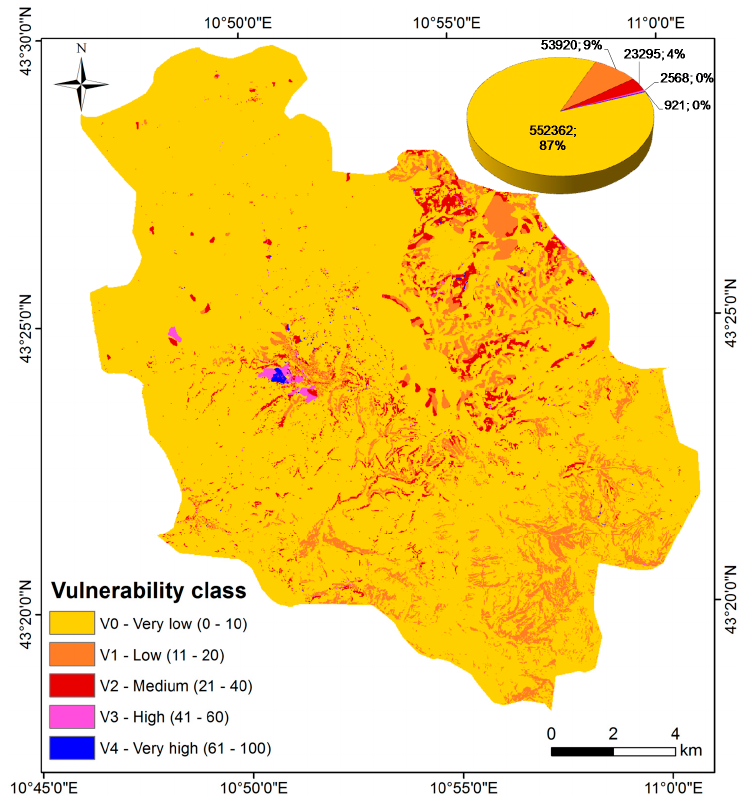
Figure 8. Vulnerability map. The pie chart shows number of pixels and related percentage for each Intensity class. The 0% percentages of Intensity classes V3 and V4 actually correspond to decimal values 0.004 and 0.001, respectively.